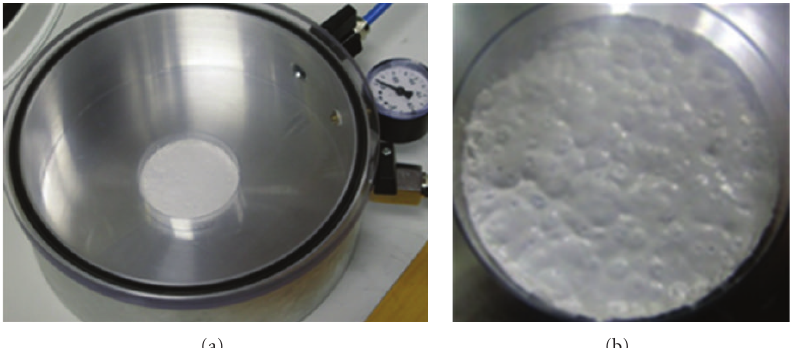
Figure 4: (a) Small degassing chamber, to degas the final composite mixture in room temperature. (b) Extraction of air bubbles from the surface of the composite mixture during degassing.